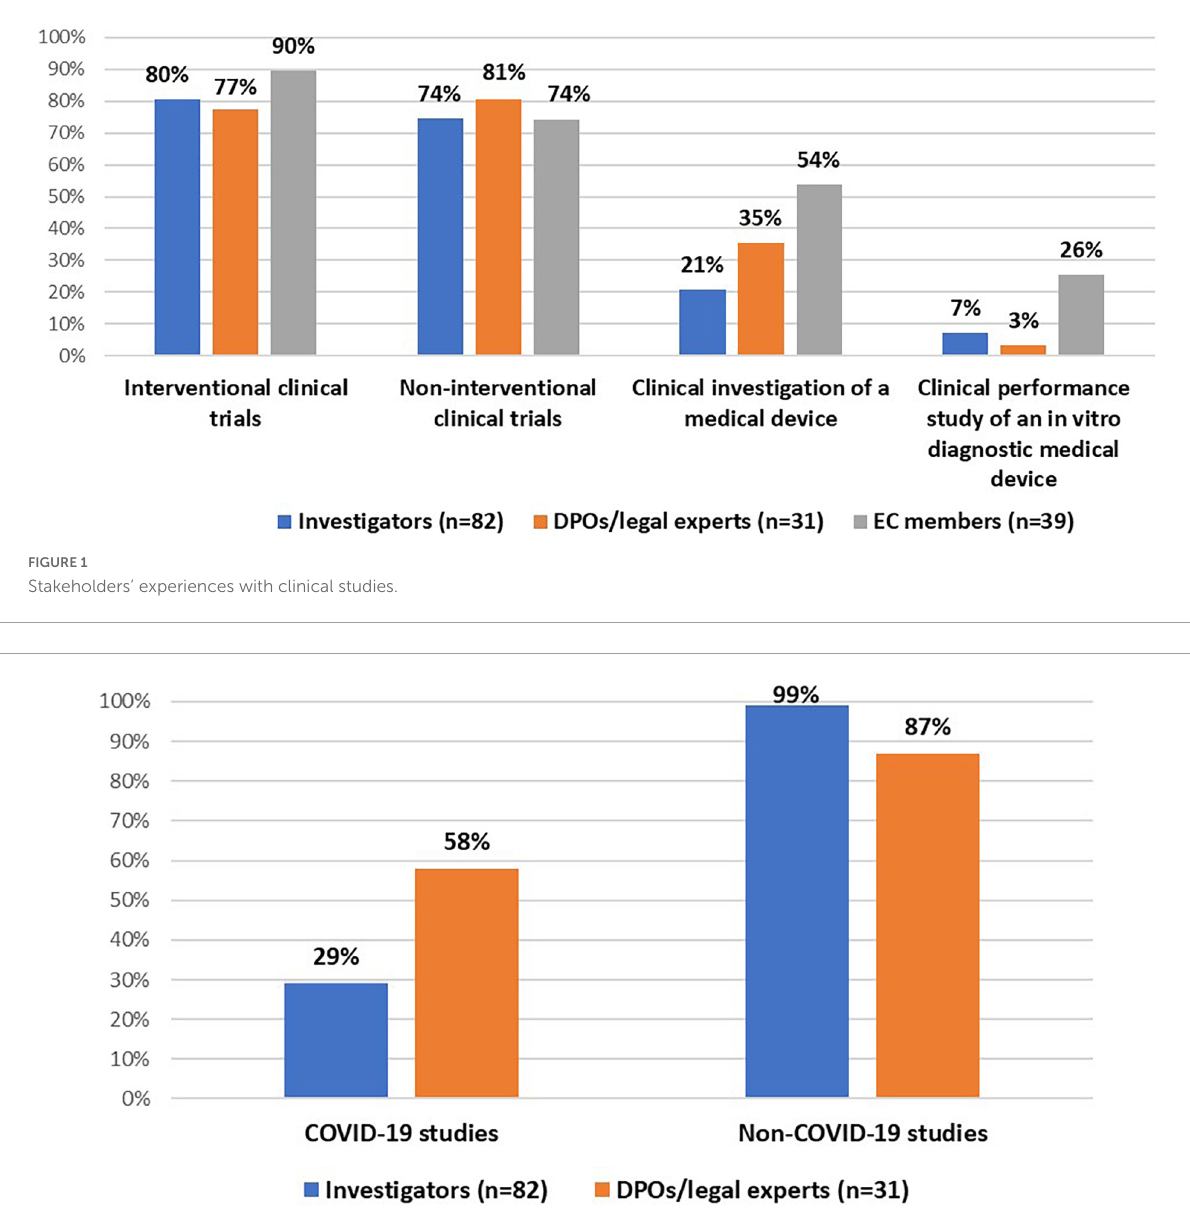
FIGURE2 Stakeholders’ experiences with COVID-19 and non-COVID-19